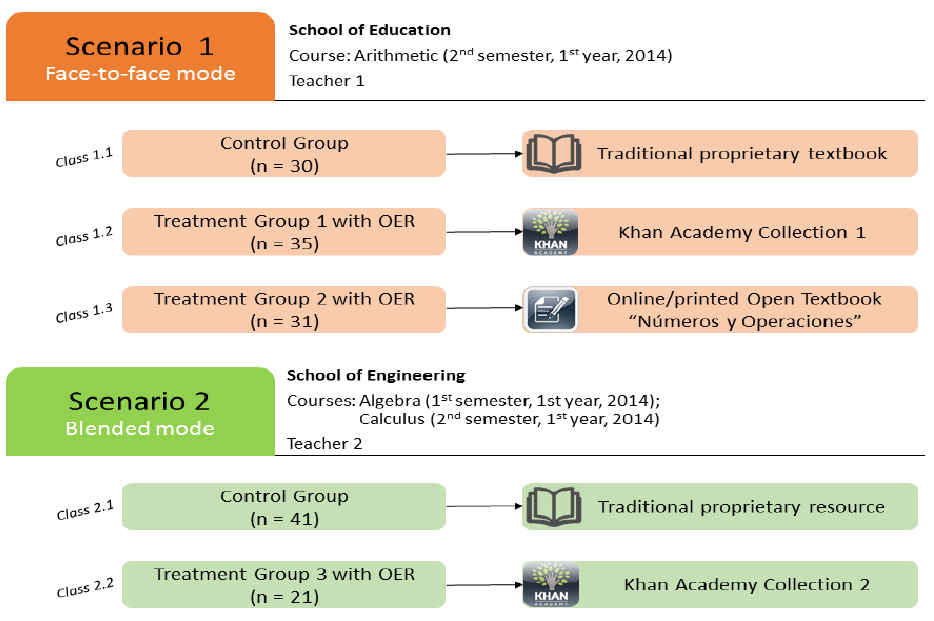
Figure 1. Overview of scenarios comprising the